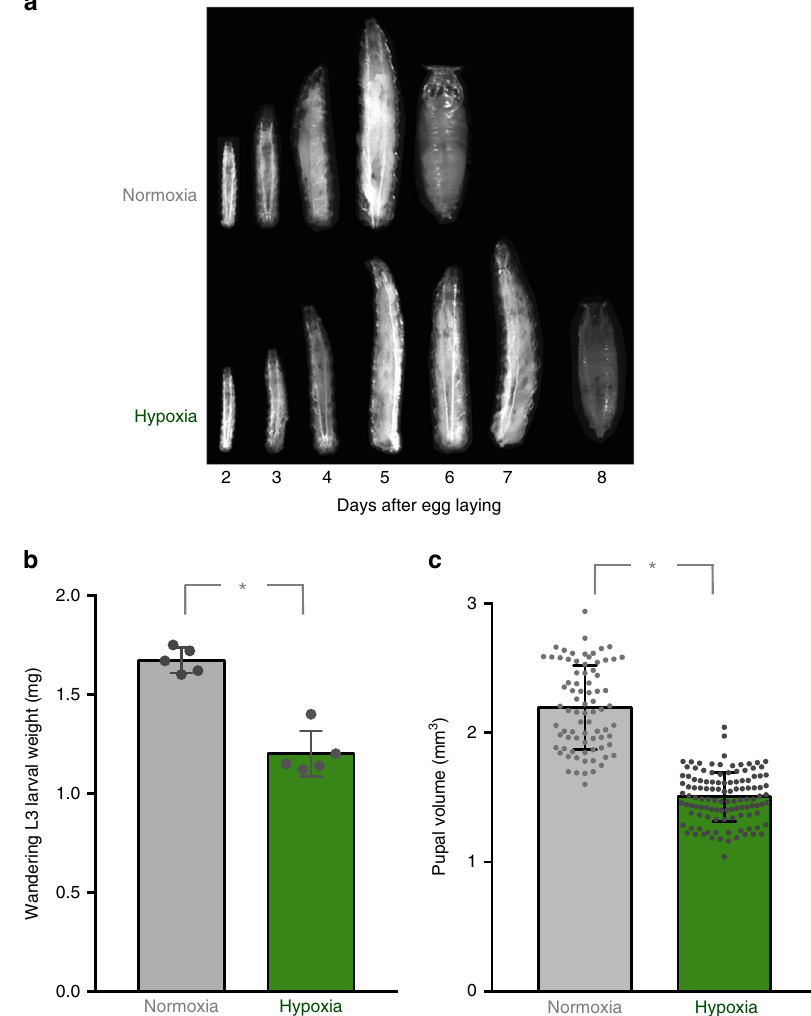
Fig. 1 Hypoxia inhibits larval growth and development. a Larvae were hatched in normoxia and then either maintained in normoxia (top images) or transferred to hypoxia (5% oxygen, bottom images). Larvae and pupae were then subsequently imaged on each day following egg hatching. Hypoxia led to a delay in larval growth and development. b Larvae were hatched in normoxia and then maintained in either normoxia or hypoxia (5% oxygen) until the wandering third instar stage. Larval weights were then measured. Hypoxia led to a reduction in larval mass. Data are expressed as mean ± SEM. * p < 0.05, Students t -test. c Larvae were hatched in normoxia and then maintained in either normoxia or hypoxia (5% oxygen) until pupation. Pupal size was then measured. Hypoxia lead to a reduction fi nal pupal size. Data are expressed as mean ± SEM, * p < 0.05, Students